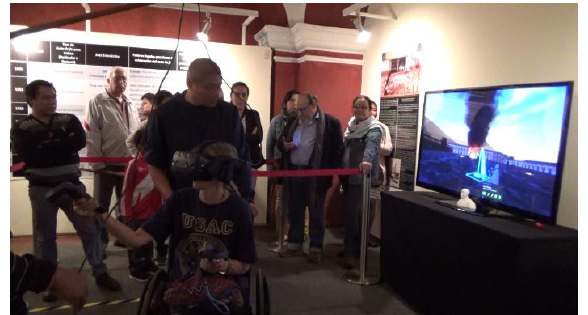
Figure. 12. A disabled person enjoying the experience. She